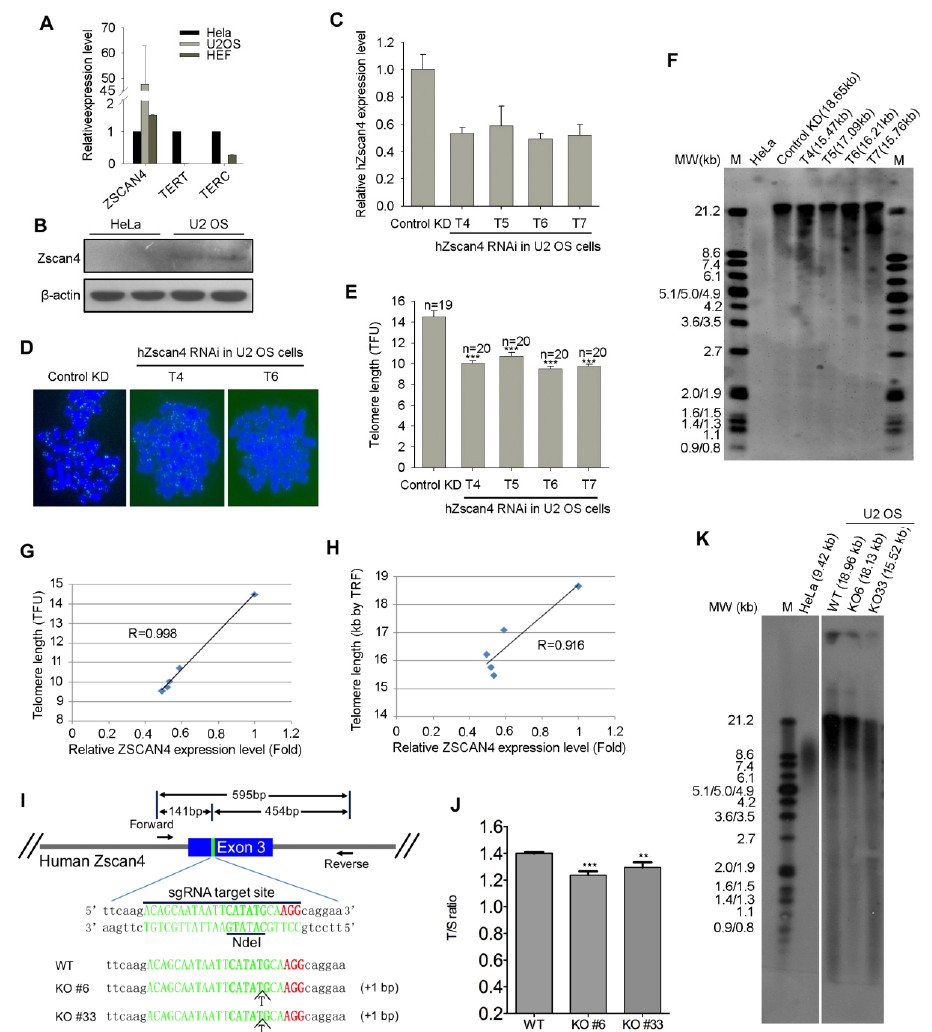
Figure 5. Depletion of ZSCAN4 in ALT U2 OS cells shortens telomere length. ( A , B ) Human ZSCAN4 is highly up-regulated in ALT positive U2 OS cells compared to ALT negative HeLa cells, analyzed by qPCR ( A ) and Western blotting ( B ). ( C ) Stable knockdown efficiency of ZSCAN4 analyzed by qPCR with four different ZSCAN4RNAi sequences. ( D ) Representative telomere specific PNA-FISH image of control and stable ZSCAN4 KD U2 OS cells. Image of control KD cells shows telomere length heterogeneity, typical ALT cell characteristics of human cancer cells. ( E ) Quantitative telomere length of control and ZSCAN4 stable KD U2 OS cells. The error bars indicate mean of telomere length ± SEM ( n = 19–20 chromosome spreads). TFU, telomere fluorescence unit. ***, p < 0.0001, compared to control KD. ( F ) TRF analysis of control and stable ZSCAN4 KD U2 OS cells. A volume of 1.5 μ g of DNA was digested and separated on a 0.8% agarose gel. M indicates a set of DNA size markers, and MW refers to DNA sizes in kilobases. Telomere length was measured using Telomeric version 1.2 software, and the median telomere length of each lane was given upper the gel. ( G , H ) Human ZSCAN4 expression levels after RNAi with different targeting sequences are highly correlated with relative telomere length analyzed by QFISH (R = 0.998) ( G ) and TRF assay (R = 0.916) ( H ). ( I ) Targeted disruption of ZSCAN4 gene by CRISPR/Cas9 technology in U2 OS cells. The designed sgRNA targeting human ZSCAN4 gene exon 3 is underlined, and the protospacer-adjacent motif (PAM) sequence labeled in red. By sequencing, two independent homologous KO clones were identified by insertion of a T at the restriction site. ( J , K ) ZSCAN4 KO in U2 OS cells shortens telomere length as analyzed by real time qPCR shown as T/S ratio ( J ) and TRF assay ( K ). Telomere length shown in ( J ) and ( K ) represents mean telomere length. Error bars indicate mean ± SEM ( n = 3). **, p < 0.01, ***, p < 0.001, compared to